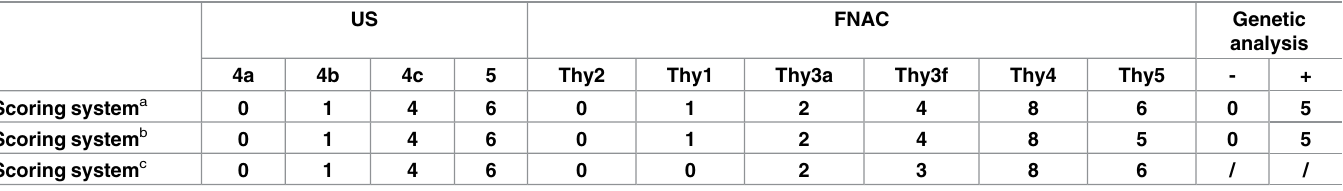
a The score system included US, FNAC and genetic analysis including BRAF V600E mutation and RET/PTC arrangements. b The score system only included US, FNAC and BRAF V600E mutation except RET/PTC rearrangements. c The score system only included US and FNAC, which was suitable for basic